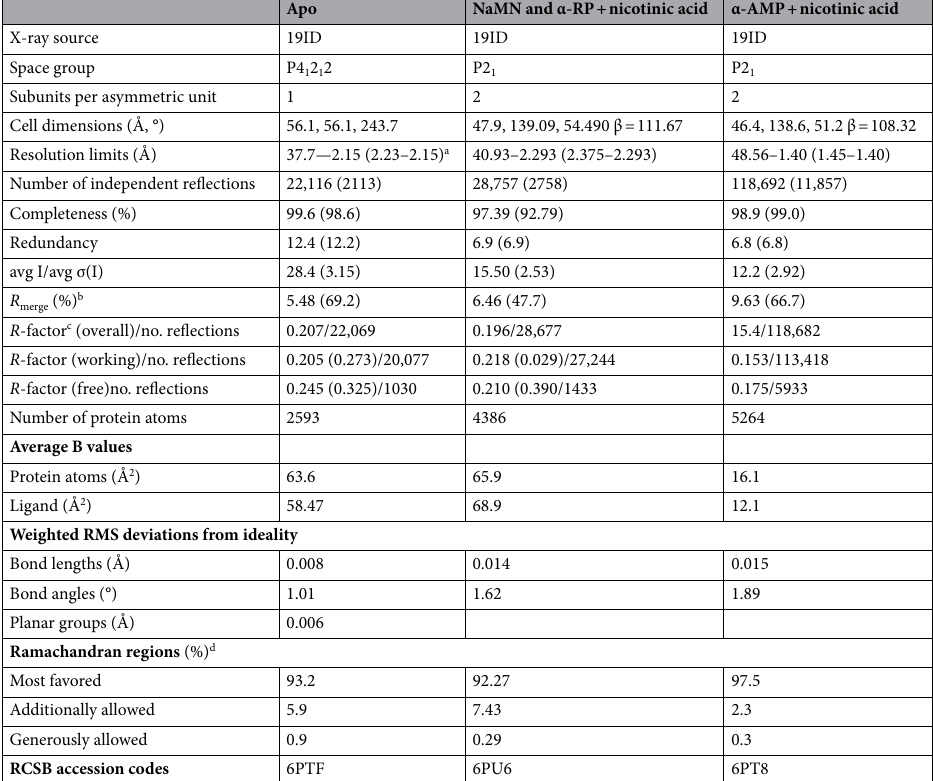
Table 1. X-ray data collection and model refinement statistics. a Statistics for the highest resolution bin. b